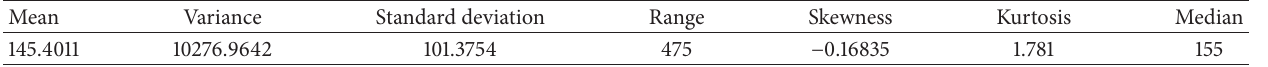
Table 1: Descriptive statistics of daily average temperature of Zhengzhou (1951–2013).